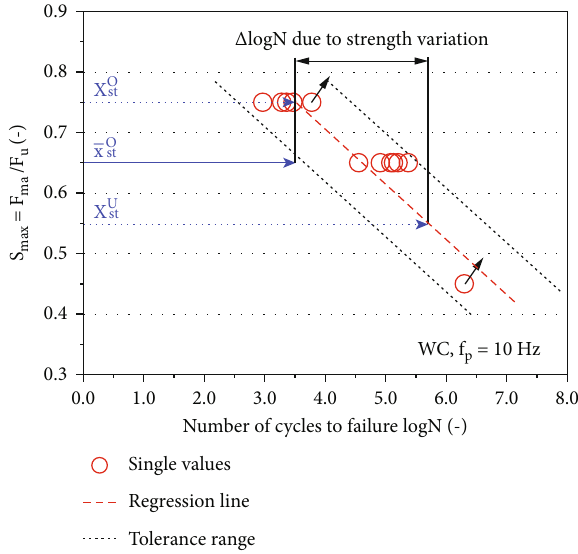
Figure 4: Example of fatigue life change due to static strength